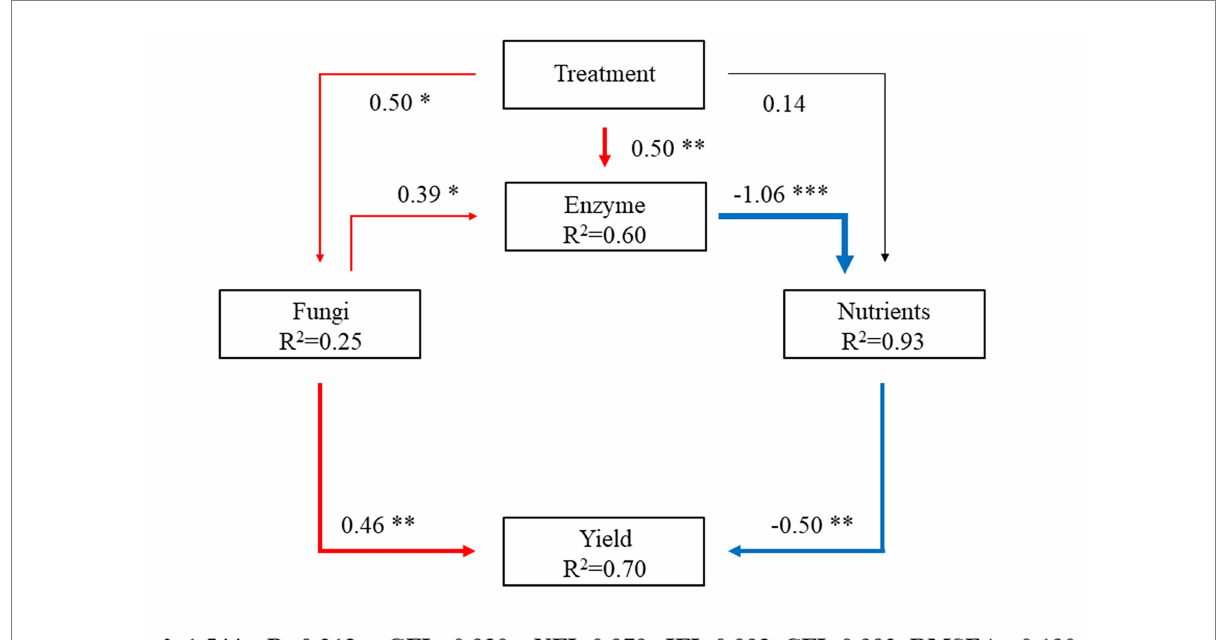
FIGURE 8 The values above the structural equation model (SEM) lines indicate path coefficients. The red line represents positive path coefficients, the blue line represents negative path coefficients, and the black line represents nonsignificant path coefficients. The width of the arrow indicates the significance of the standard path coefficient ( *** p < 0.001; ** p < 0.01; * p <